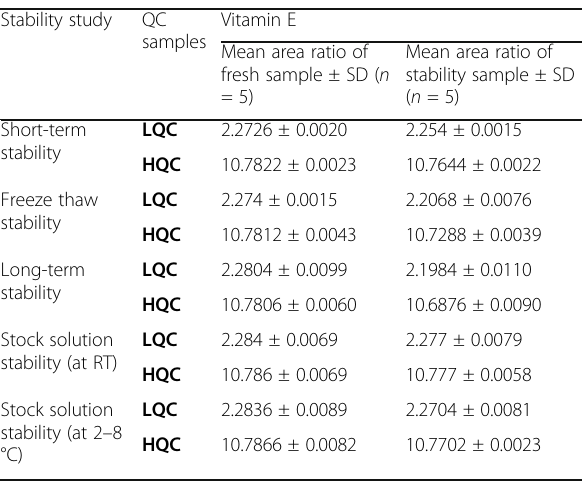
Table 8 Stability parameters for developed bioanalytical method Stability study QC Vitamin E samples